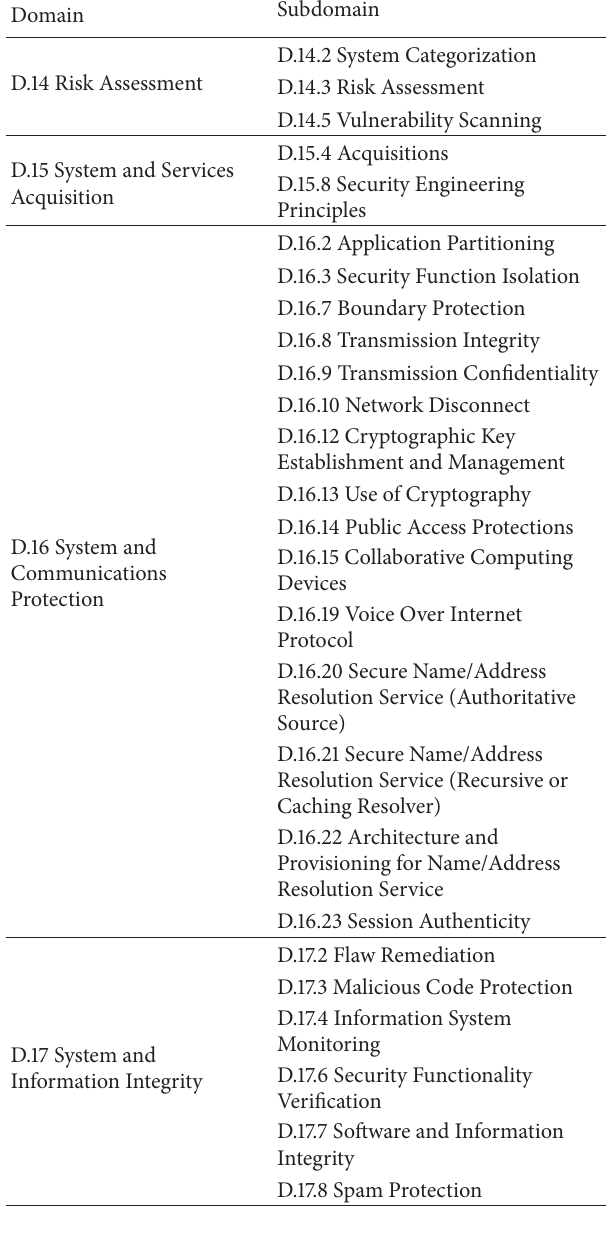
Table 4: The domain and subdomain of NIST SP 800-53 for an ICS.